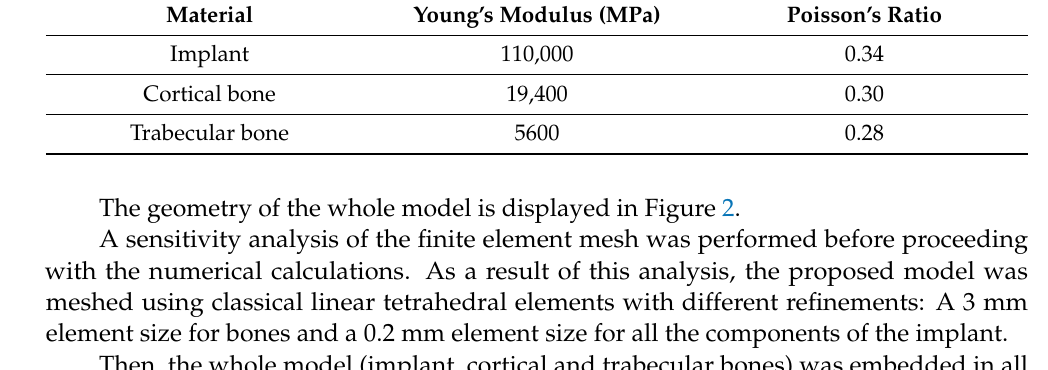
Table 1. Mechanical properties of all the model’s materials. Material Young’s Modulus (MPa) Poisson’s Ratio Implant 110,000 Cortical bone